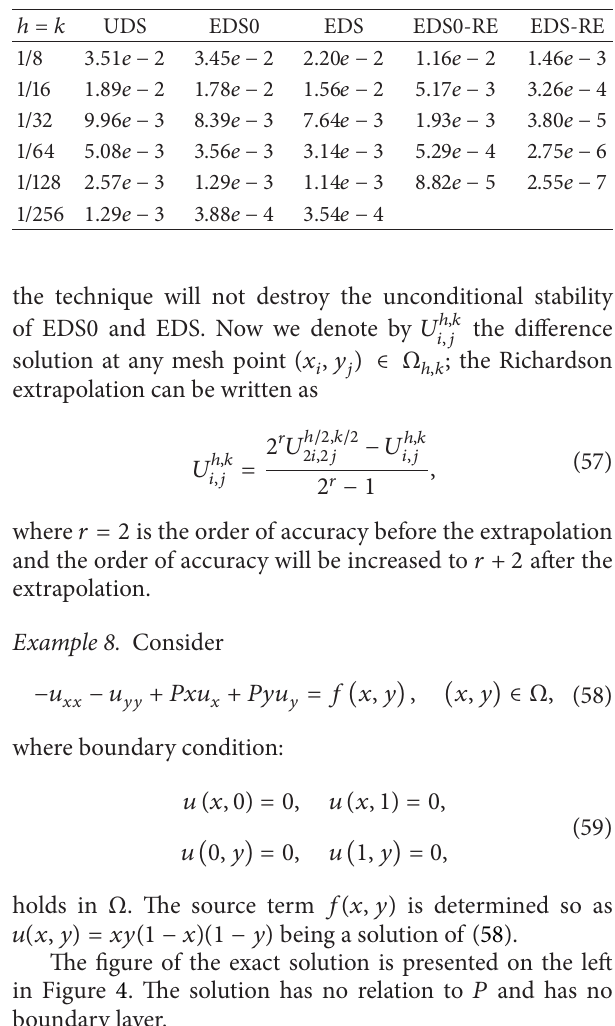
Table 5: Maximum absolute errors in the computed solution, Example 8 with 𝑃 = 1000